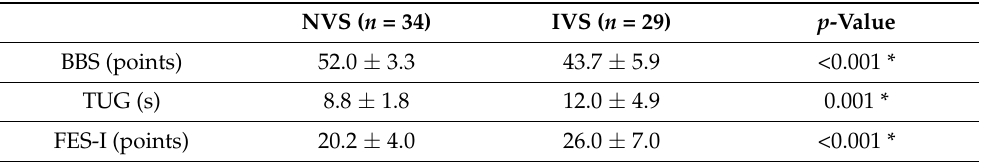
Table 4. Functional balance and fear of falling in patients with DM with NVS vs. IVS according to VPT